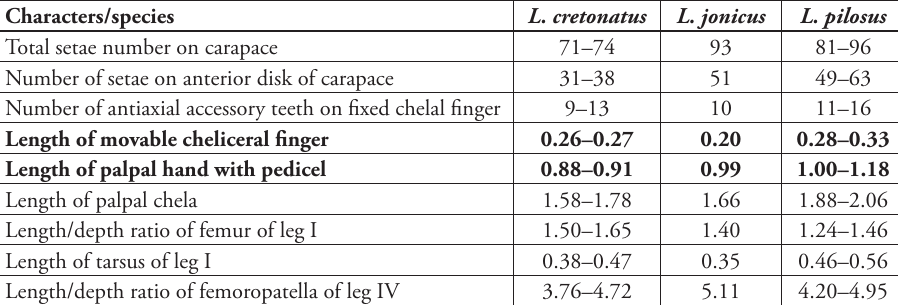
Table 4. Comparison of adult females of L . cretonatus , L . jonicus , and L . pilosus in values of most dif- ferentiating morphological characters (measurements in mm). Boldface values indicate the characters that unambiguously differentiate all the three species.